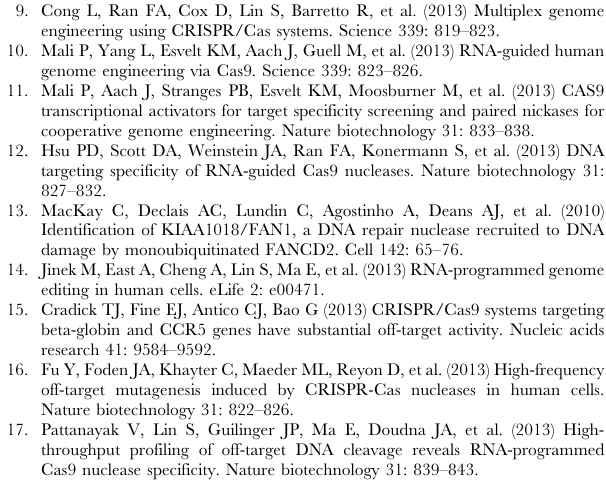
Table S1 Primers needed for sgRNA generation. List of sgRNA targeting human genome with the sequence of the forward primers needed to generate sgRNA. (ZIP) Protocol S1 Details of the protocols used to generate a sgRNA and human KO cells.